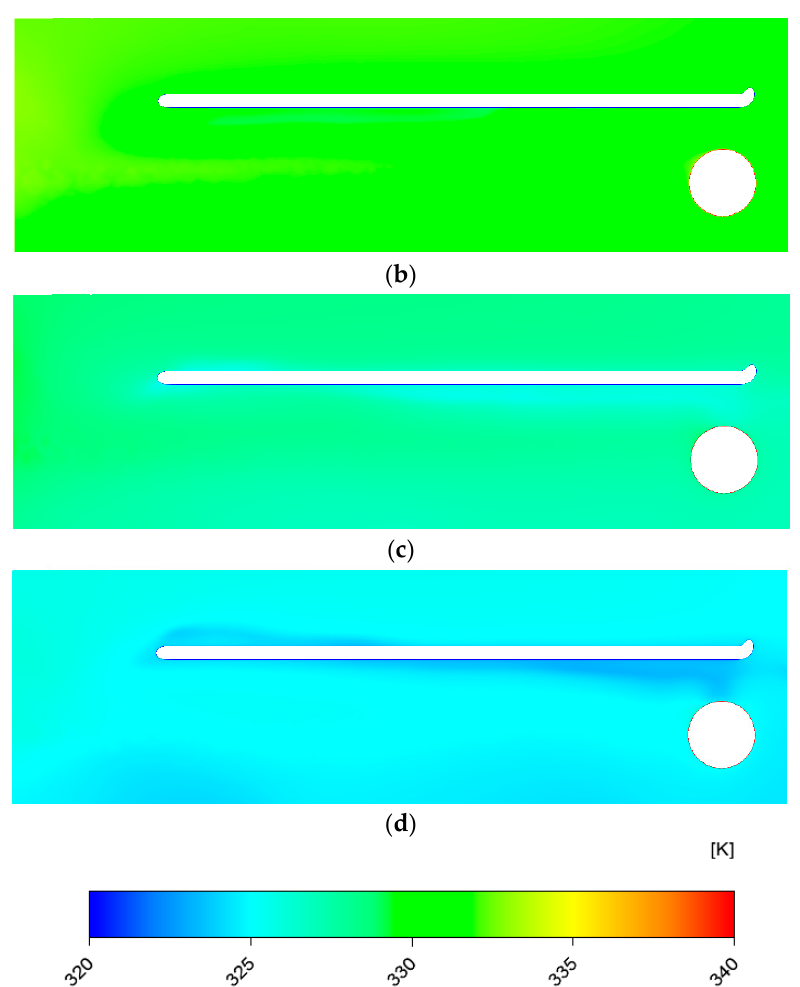
Figure 14. The temperature distribution across the middle (X = 0) at various inlet mass flow rates: ( a ) m(cid:4662) = 60,000 SCMH (16.67 m 3 /s), ( b ) m(cid:4662) = 80,000 SCMH (22.22 m 3 /s), ( c ) m(cid:4662) = 100,000 SCMH (27.78 m 3 /s), and ( d ) m(cid:4662) = 120,000 SCMH (33.33 m 3 /s).